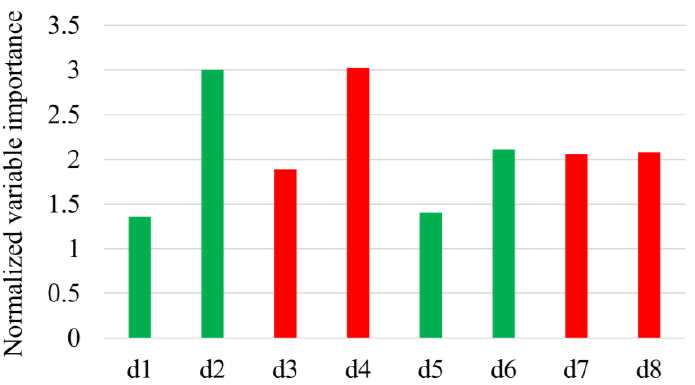
Figure 5. Normalized RF variable importance for extracted features from the simulated DP SAR data (July 21). Please note that d1 : 𝜎 𝐻𝐻0 , d2 : 𝜎 𝐻𝑉0 , d3 : 𝜎 𝑉𝑉0 , d4 : 𝜎 𝑉𝐻0 , d5 : 𝑆𝑝𝑎𝑛 1 , d6 : 𝑅𝑎𝑡𝑖𝑜 1 , d7 : 𝑆𝑝𝑎𝑛 2 , and d8 : 𝑅𝑎𝑡𝑖𝑜 2 . See Table 2 for abbreviations of features.